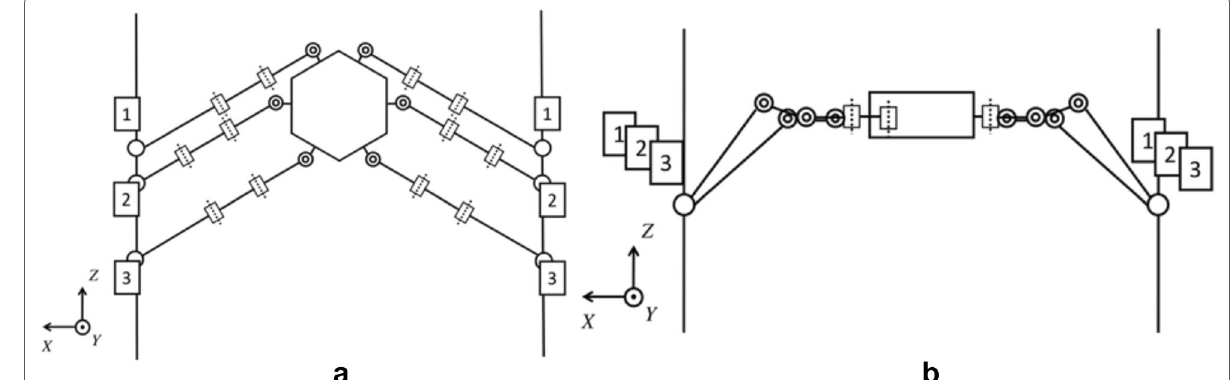
Fig. 4 Proposed gait strategy Left figure is the vertical-body climbing gait. Right figure is the horizontal-body climbing